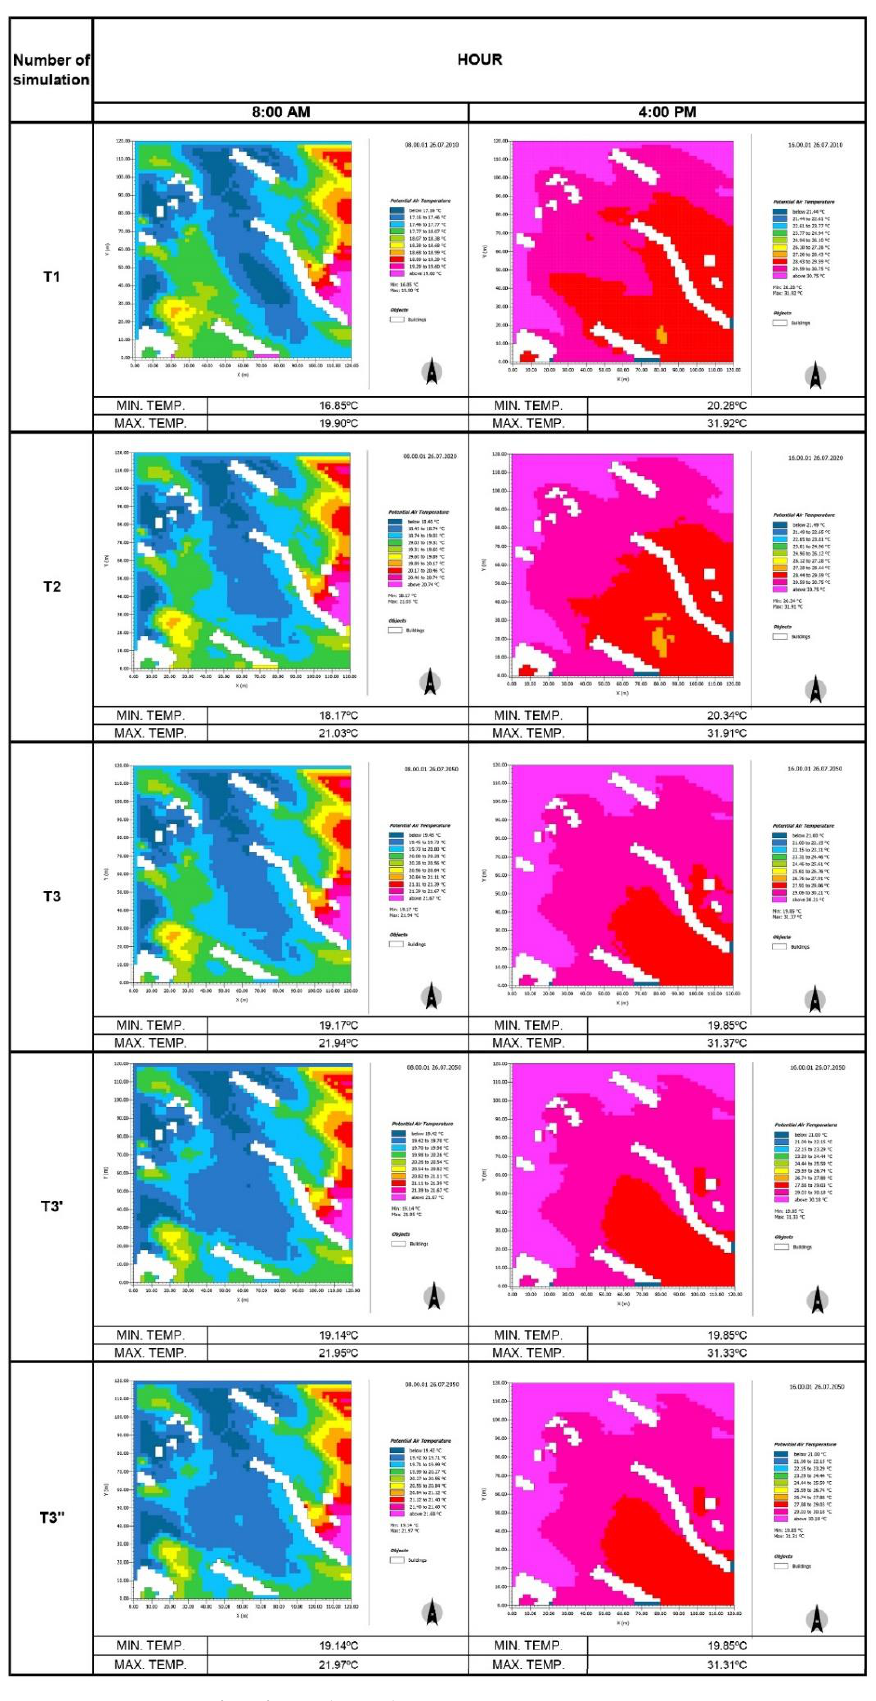
Figure 9. Summary of performed simulations .